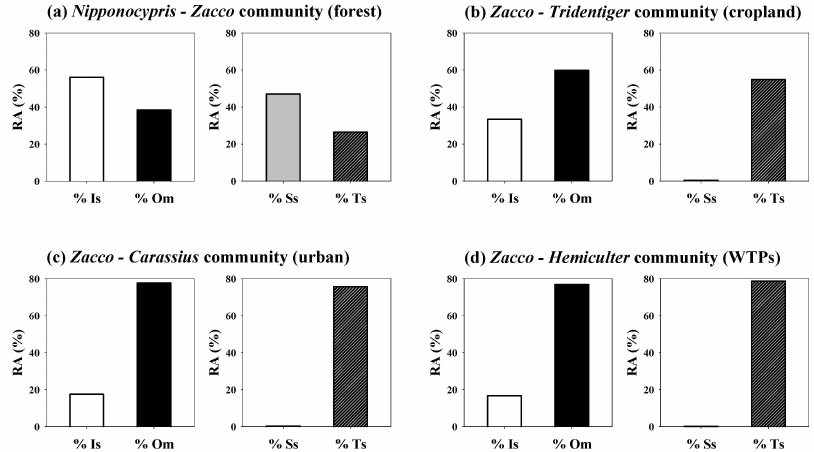
Figure 4. Trophic composition ( left panel) and tolerance level ( right panel) of fish communities in the Geum River watershed. % I s , proportion of insectivores; % O m , proportion of omnivores; % S s , proportion of sensitive species; % T s , proportion of tolerance species. ( a ) Nipponocypris-Zacco community (forest); ( b ) Zacco-Tridentiger community (Cropland); ( c ) Zacco-Carassius community (urban); and ( d ) Zacco-Hemiculter community